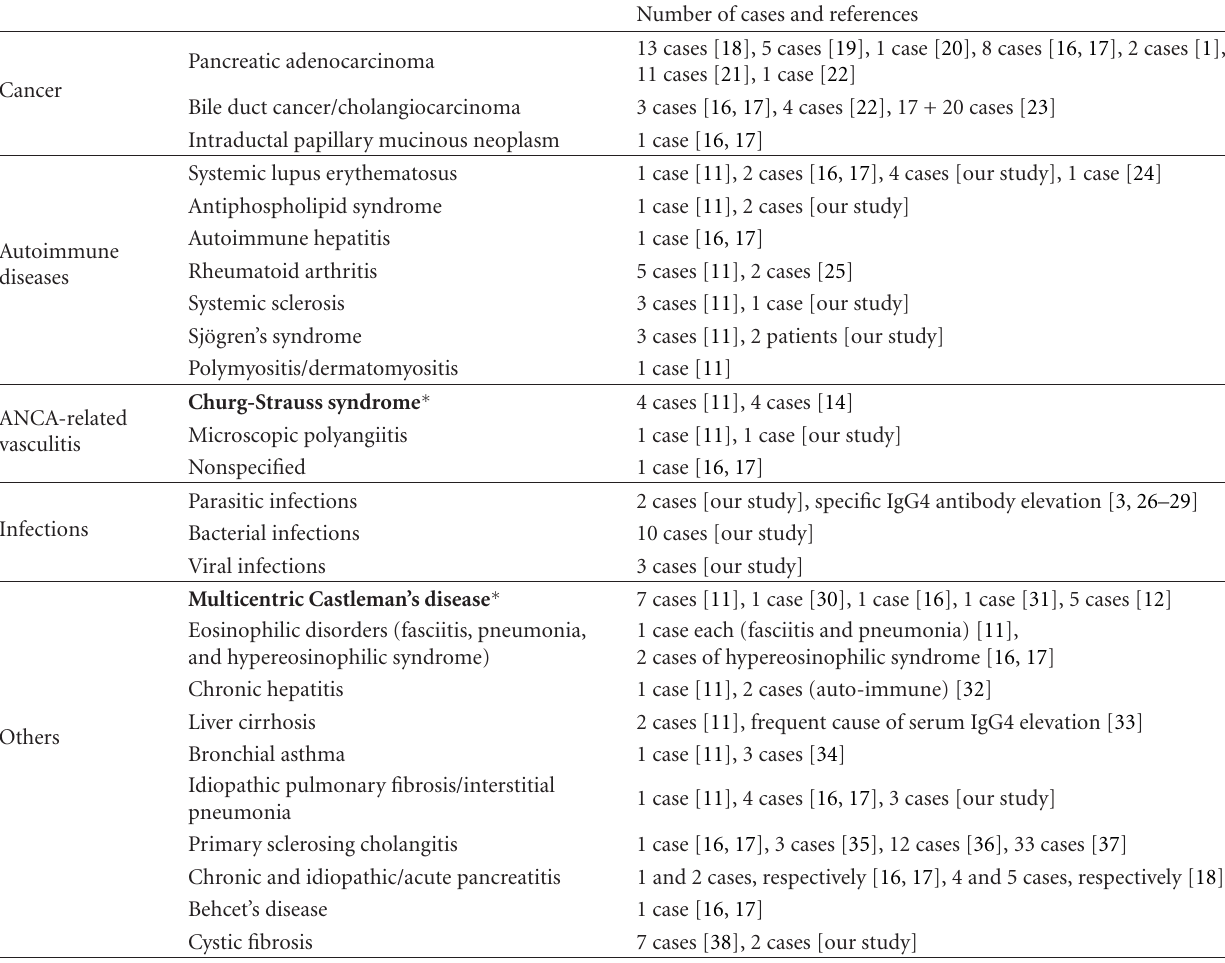
Table 3: Pathologies (excepted IgG4-RD organ involvements) associated to serum IgG4 elevation in medical